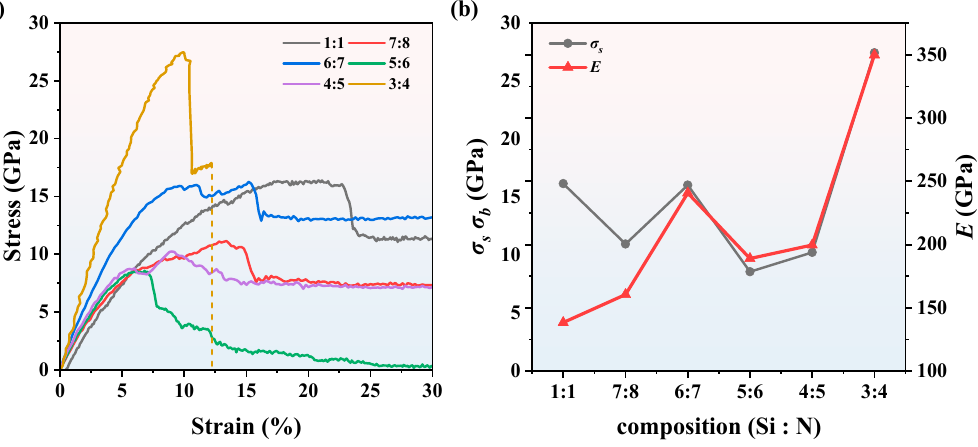
Figure 12. ( a ) The strain–stress curves of SiN x at 300 K. ( b ) The mechanical properties of SiN x .